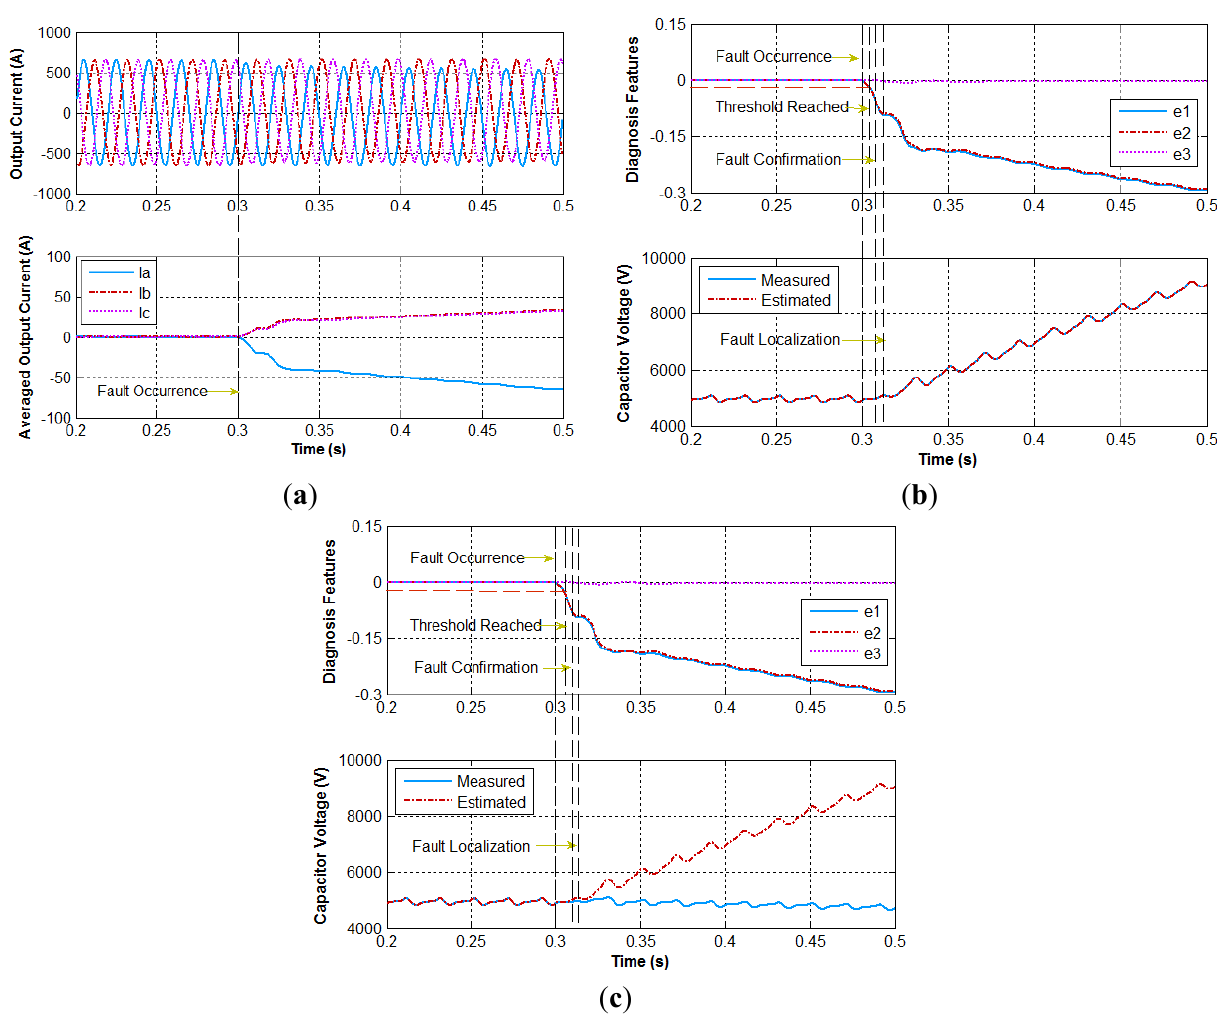
Figure 12. Open-circuit fault in T 2 under 20MW. ( a ) Output current and their averaged values; ( b ) Diagnosis features and capacitor voltages in SM1; ( c ) Diagnosis features and capacitor voltages in